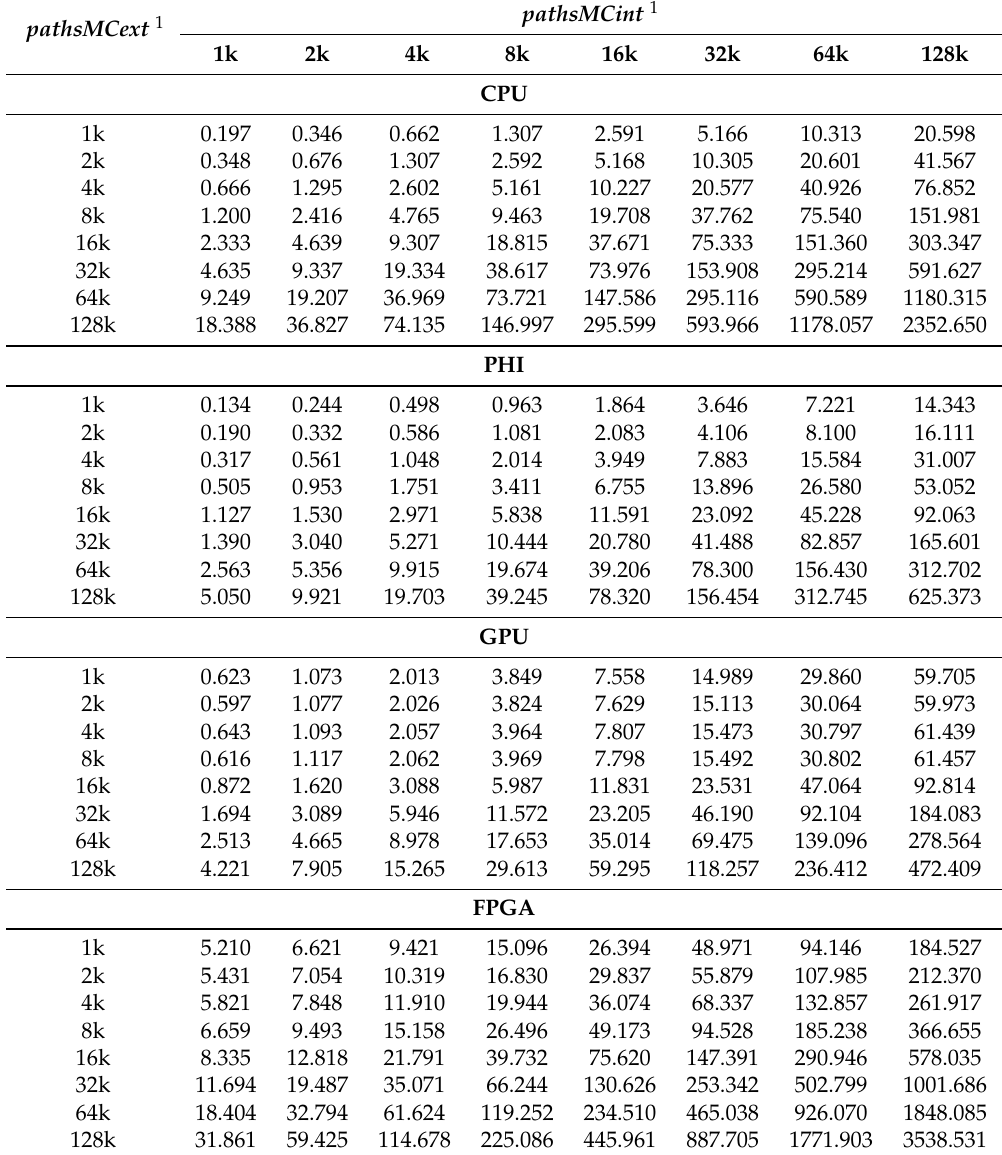
Table 6. Kernels runtime (s) scaling in the BS